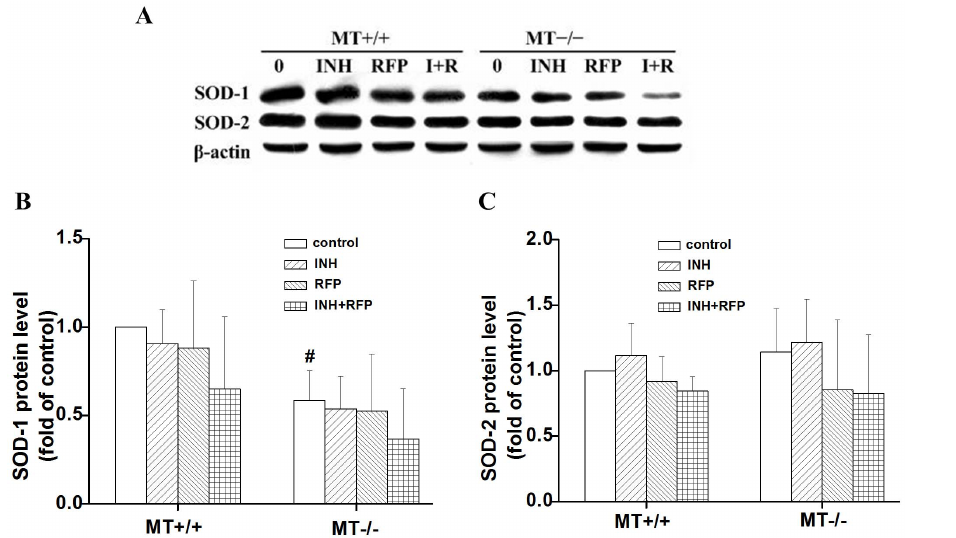
Figure 3. Effect of INH and RFP treatment on the expressions of SOD-1 and SOD-2 in wild-type (MT + / + ) and MT 2 / 2 mice. The expression of SOD-1 and SOD-2 was analyzed by Western blotting. The control values of SOD-1 in MT 2 / 2 mice and MT + / + were not identical, SOD-1 protein in MT 2 / 2 mice was significantly lower than that in wild-type mice. # p , 0.05, compared with MT + / + mice for the same treatment. doi:10.1371/journal.pone.0072058.g003 PLOS ONE |